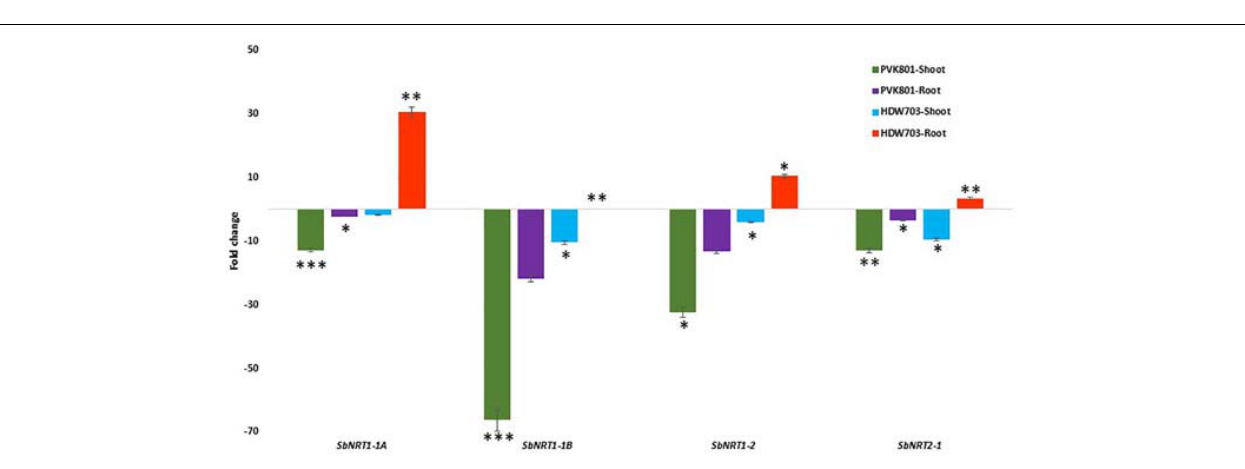
Frontiers in Plant Science |